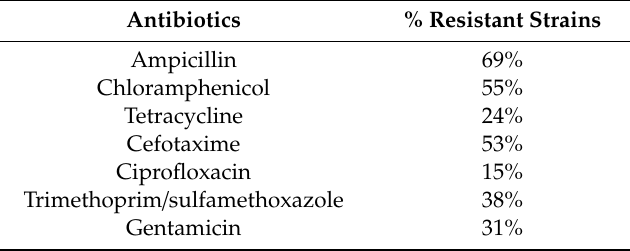
Table 2. Percentage of antibiotic resistance of the isolated bacterial strains from both haemodialysis centres. Antibiotics % Resistant Strains